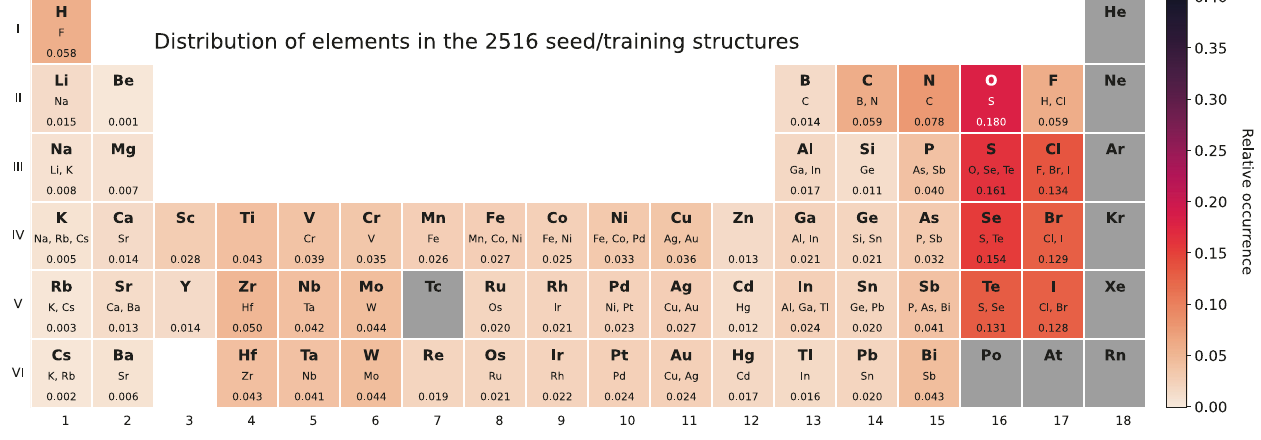
Fig. 1 Heat map of the relative occurrence of each element in the 2D materials used to train (seed) the CDVAE (LDP). The middle row shows the element substitutions for the LDP corresponding to P AB > 0.1. The relative occurrence is shown in the last